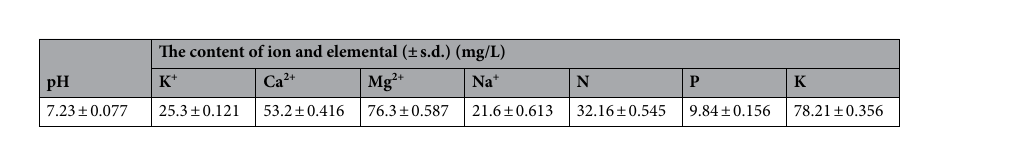
Table 2. Properties and composition of the soil in the Fushun Mining area.